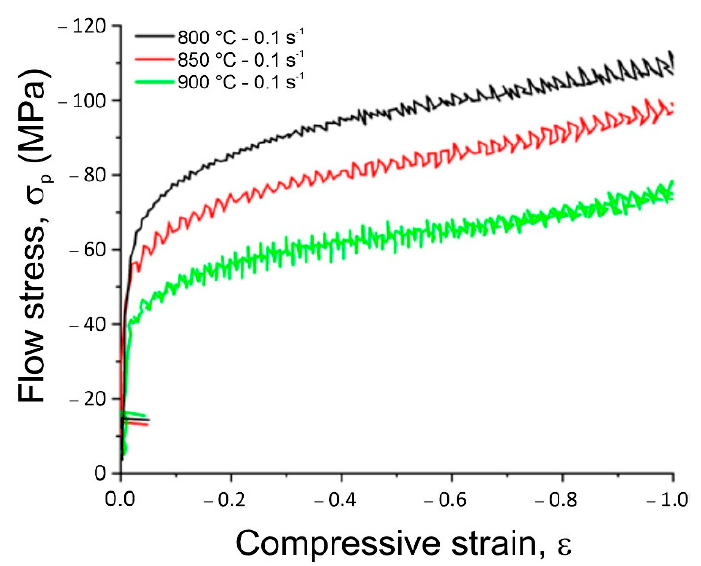
Figure 7. Influence of the strain temperature on the shape of stress–strain curves of the CuNiSi alloy after real deformation: ε = 1, at a constant rate of strain equal to 1 s − 1 .